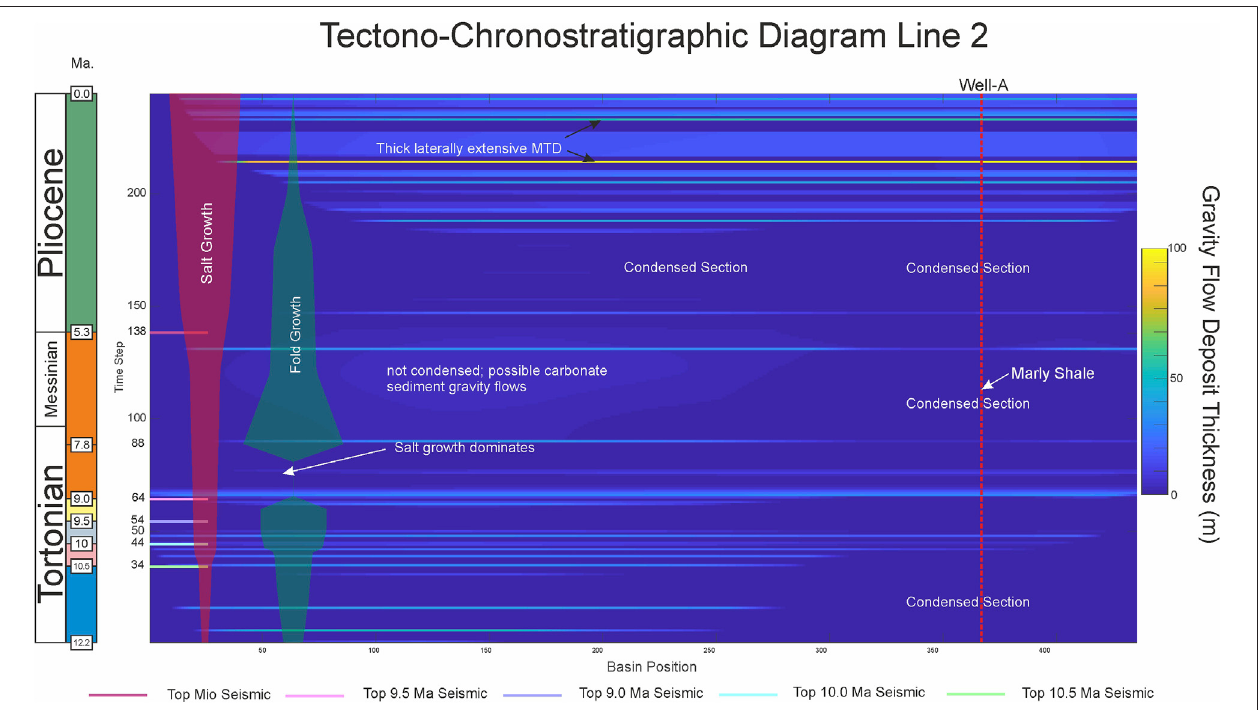
FIGURE 11 | Tectono-Chronostratigraphic chart of Line 2, highlighting the temporal and spatial distribution of gravity fl ow deposits as well as their thicknesses. Superimposedontothechartarerepresentationsofthetwostructuralgrowthpro fi lesusedinmodellingLine2.Thewidthofthesepro fi lesrepresentstherelativestrength that each pro fi le exerts of the overall structural growth of Line 2. Salt Growth (Pro fi le 2) is continuous through time, while Fold Growth (Pro fi le 1) has two distinct phases, and can be seen to decrease rapidly in the Pliocene. Well-A shows multiple condensed sections in which no gravity fl ow deposits are intercepted. Section labelled “ not condensed ” is where Onlapse-2D had to introduce a small but continuous rise to the Clastic Limiting Surface, this deposited thin gravity fl ow deposits that onlap onto fl anks of High-1.